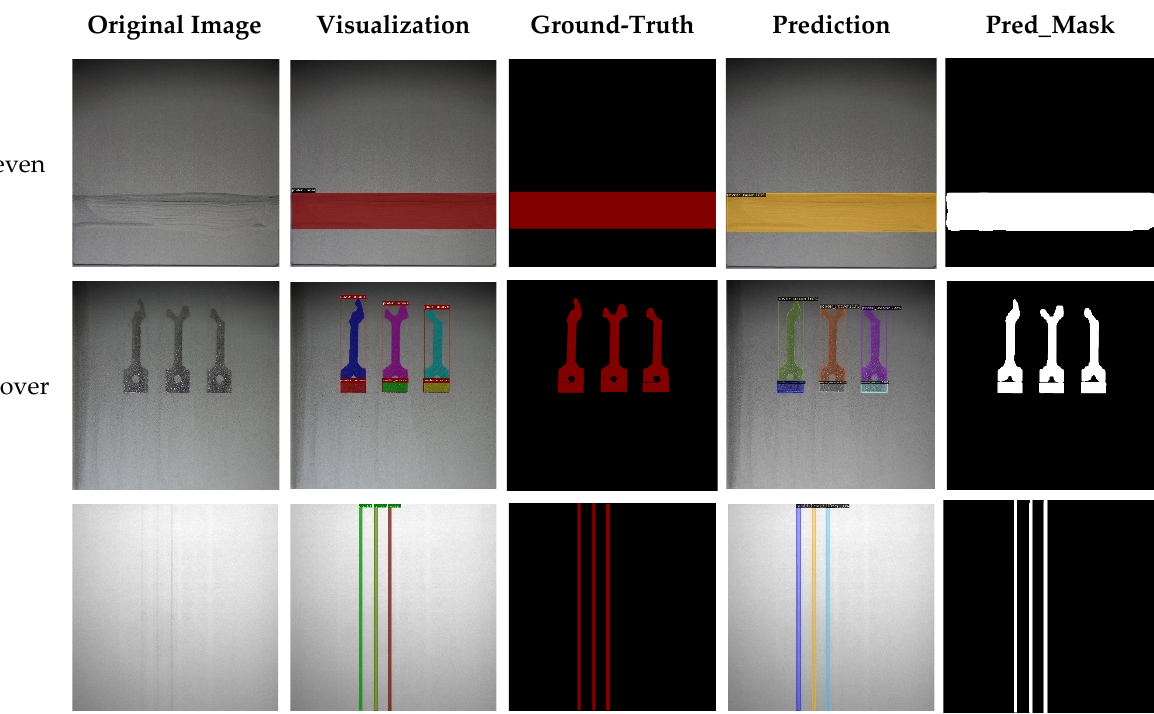
Figure 6. Samples for Mask R-CNN predictions.